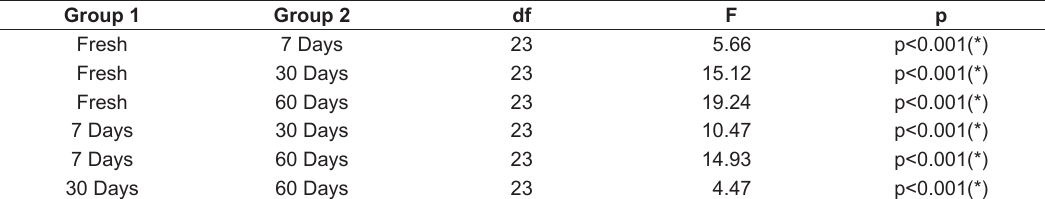
Table 3. ANCOVA pairwise comparison of slopes by groups (treatments) using Tukey’s post-hoc test. Group